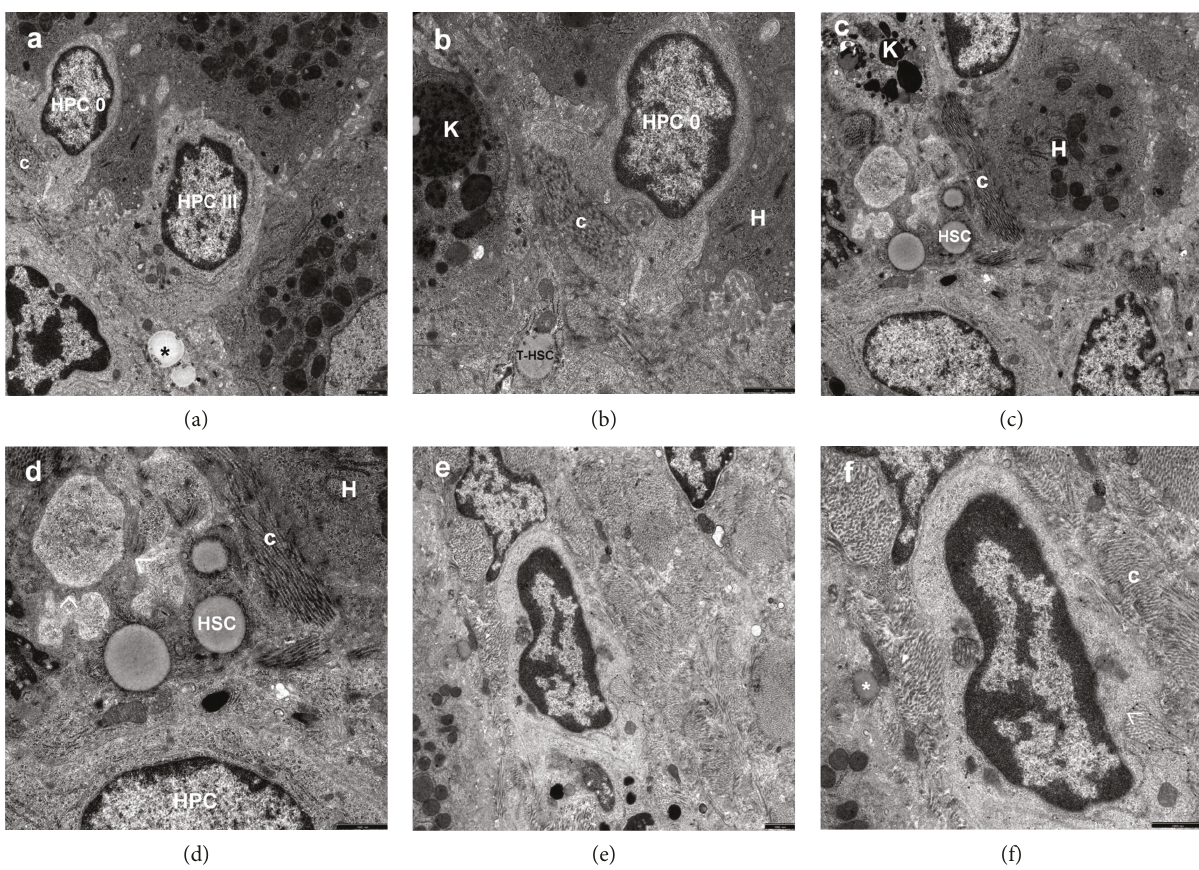
Figure 3: (a – f) Electron micrographs showing the periportal area (a, b) and the regenerative nodule periphery (c – f) 8 weeks after inducing BDL in rats. (a) A view of two HPCs (HPC 0, HPC III) pushed in a necrotizing hepatocyte located at the limiting plate of the lobule. In